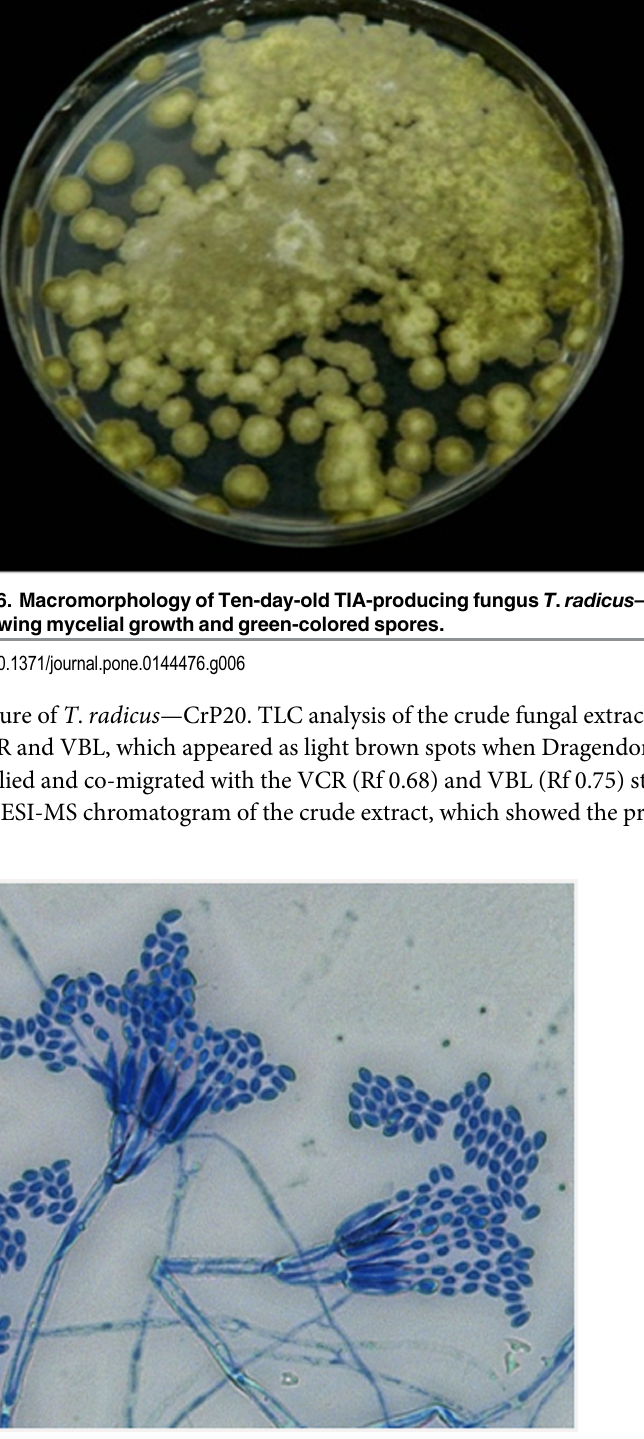
Fig 7. Micromorphology of T . radicus — CrP20, showing phialides with chains of conidia under light microscope (40X